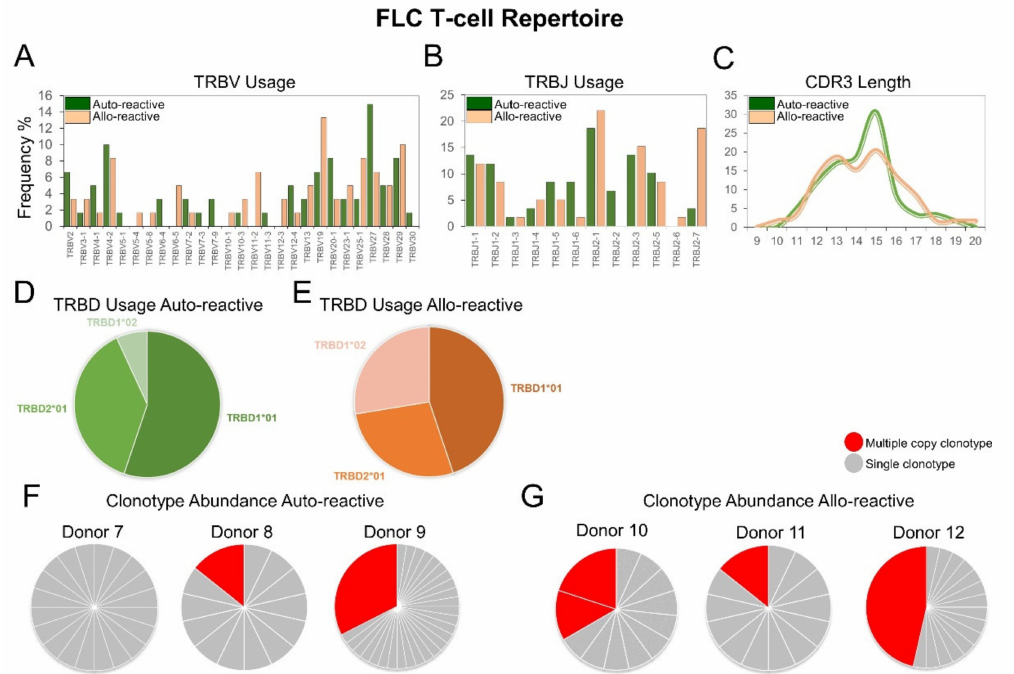
Figure 4. Different FLC-specific T-cell repertoires between auto-reactive and allo-reactive donors. Bar charts showing percentage use of ( A ) TRBV and ( B ) TRBJ preference from auto-reactive (green) versus allo-reactive (orange) donors. ( C ) Line chart comparing percentage use of CDR3 length. ( D , E ) Pie charts comparing percentage use of the TRBD genes. Pie charts showing clonotype frequencies in ( F ) three auto-reactive donors and ( G ) three allo-reactive donors. Each slice represents a unique clonotype from the repertoire of a single donor. Unique clonotypes with multiple copies are shown in red and unique clonotypes with a single copy are shown in grey. Percentages were determined by summing the total clonotypes found within a single